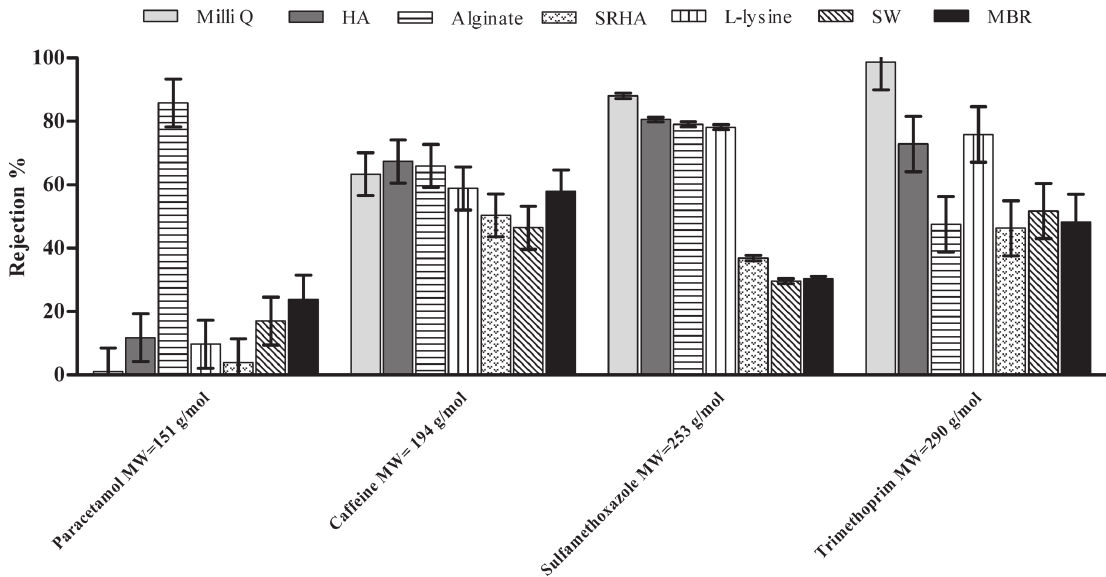
Figure 8. Rejection of hydrophilic nonionic compounds by new and fouled